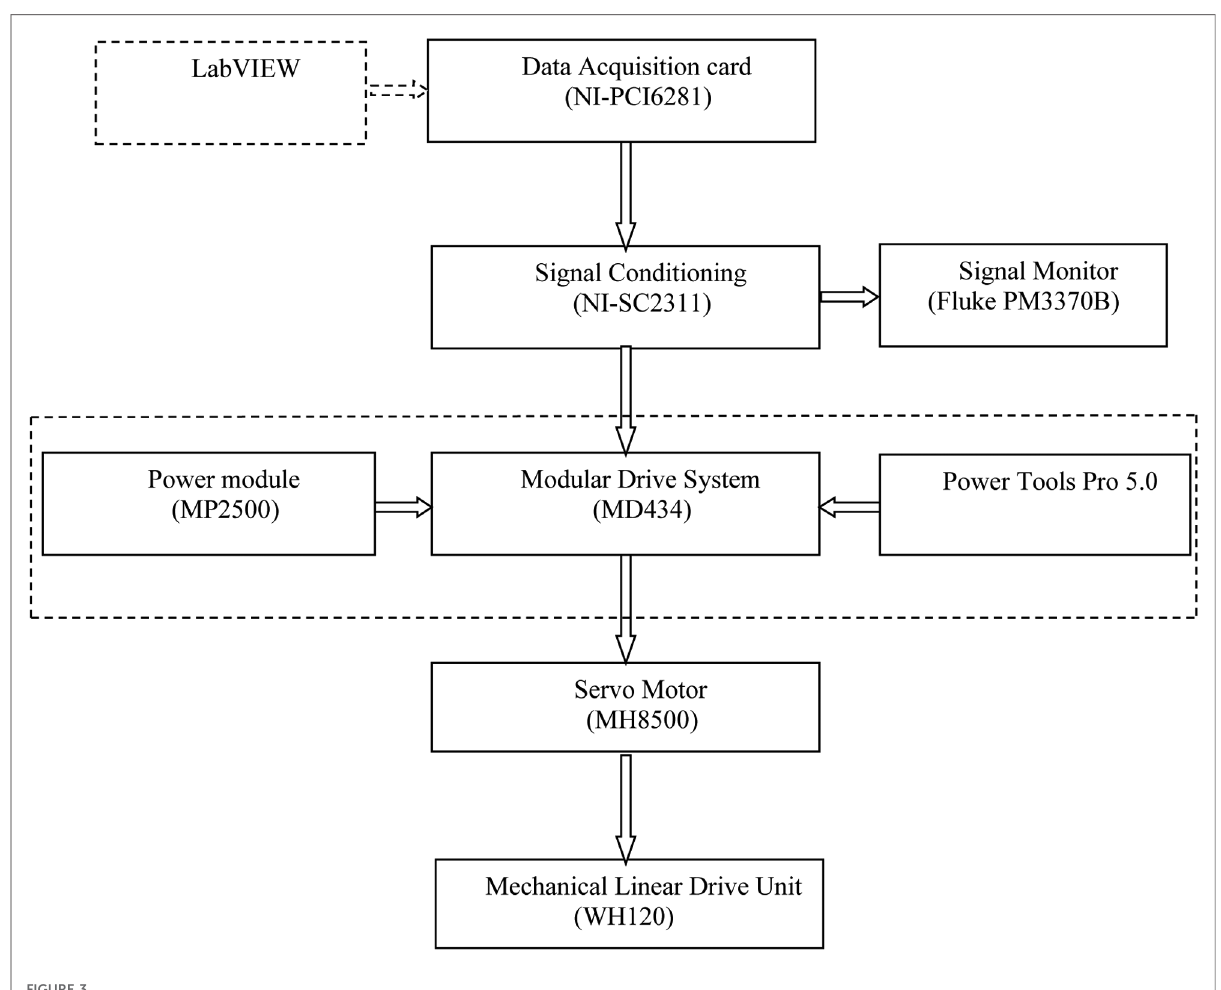
FIGURE 3 Generation of sinusoidal